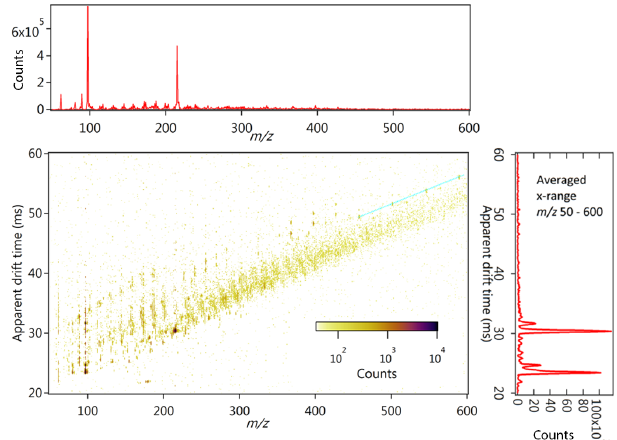
Figure 3. (a) An ESI-LC-MS filter mass spectrum (MS) extracted from the liquid chromatogram peak corresponding to the water- soluble organosulfate signal at m/z 215. The filter was taken during the SOAS campaign at the LRK site on 12 June 2013. LC is unable to resolve all of the compounds shown in the chromatogram. The ion mobility spectra for the MS peaks highlighted in (a) are shown in (b) . The IM spectra were extracted from separate mass spectra and then placed together in the graph above for clarity. The water- soluble organic compounds are resolved by the IMS–TOF. The in- tensity for the ion mobility peak at m/z 215 has been scaled by a factor of 0.5 for visibility, as indicated in the